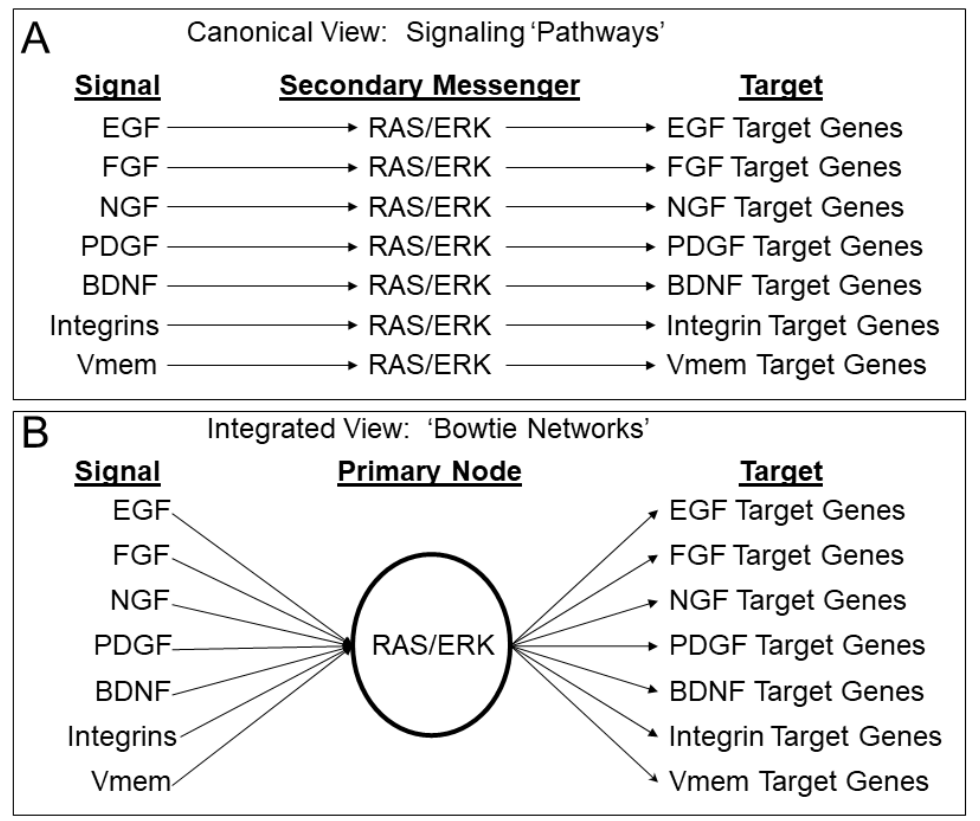
Figure 1. Secondary messengers as primary nodes: ( A ) Cell signaling is often conceptualized as pathways between signals and target genes with secondary messengers as intermediates; ( B ) because the same secondary messengers are used in many different pathways, it may be more appropriate to think of them as primary nodes integrating diverse signaling regimes.